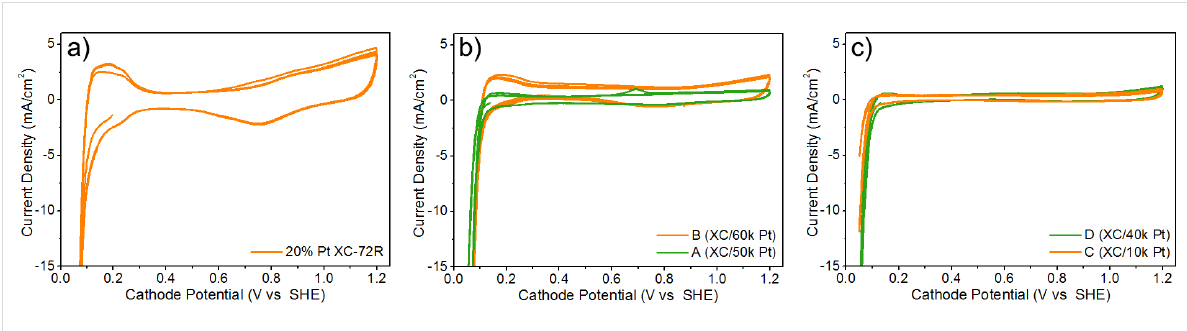
Figure 6: Cyclic voltammetry curves for Pt-based catalysts: (a) reference catalyst 20% Pt XC-72R, (b) materials A and B with Pt deposited on Vulcan XC-72R, and (c) materials C and D with Pt deposited on synthesized carbon material C-11. Curves were recorded at a scan rate of 0.01 V/s in a fuel cell with humidified N 2 (cathode) and H 2 (anode) gas feeds at ambient temperature and pressure. Each curve consist of four consecutive voltage